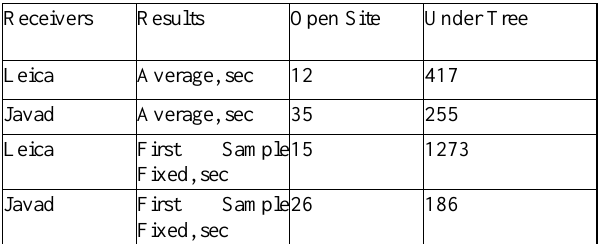
Table 1. Bucket Test Recovery